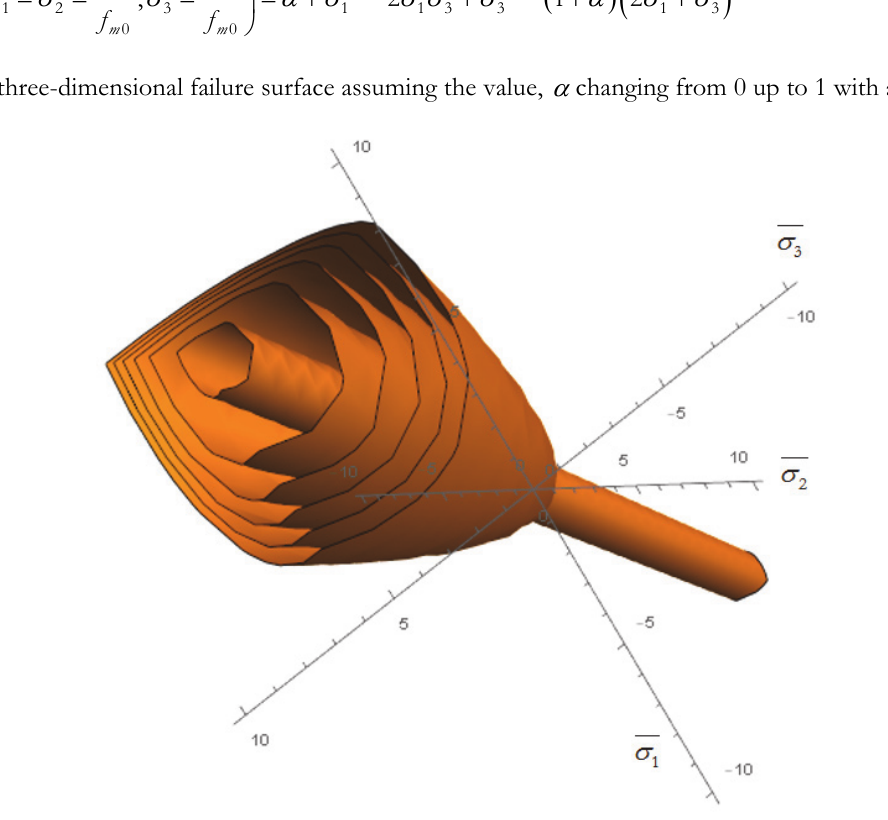
Figure 2: Failure surface according to a Stassi-D’Alia model assuming  changing from 0 up to 1 with a step of